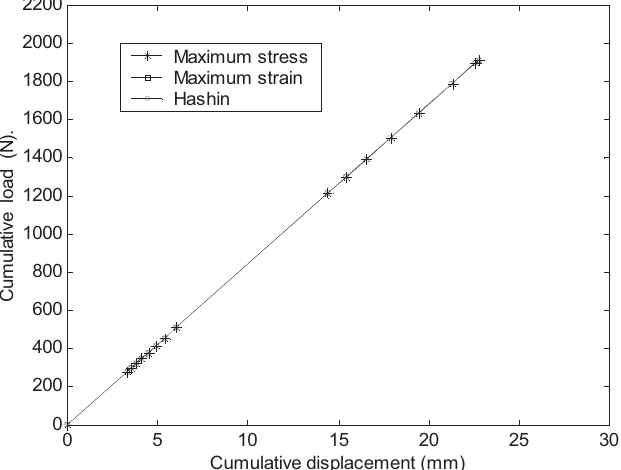
A with the limited discount method (matrix stiffness un- changed).